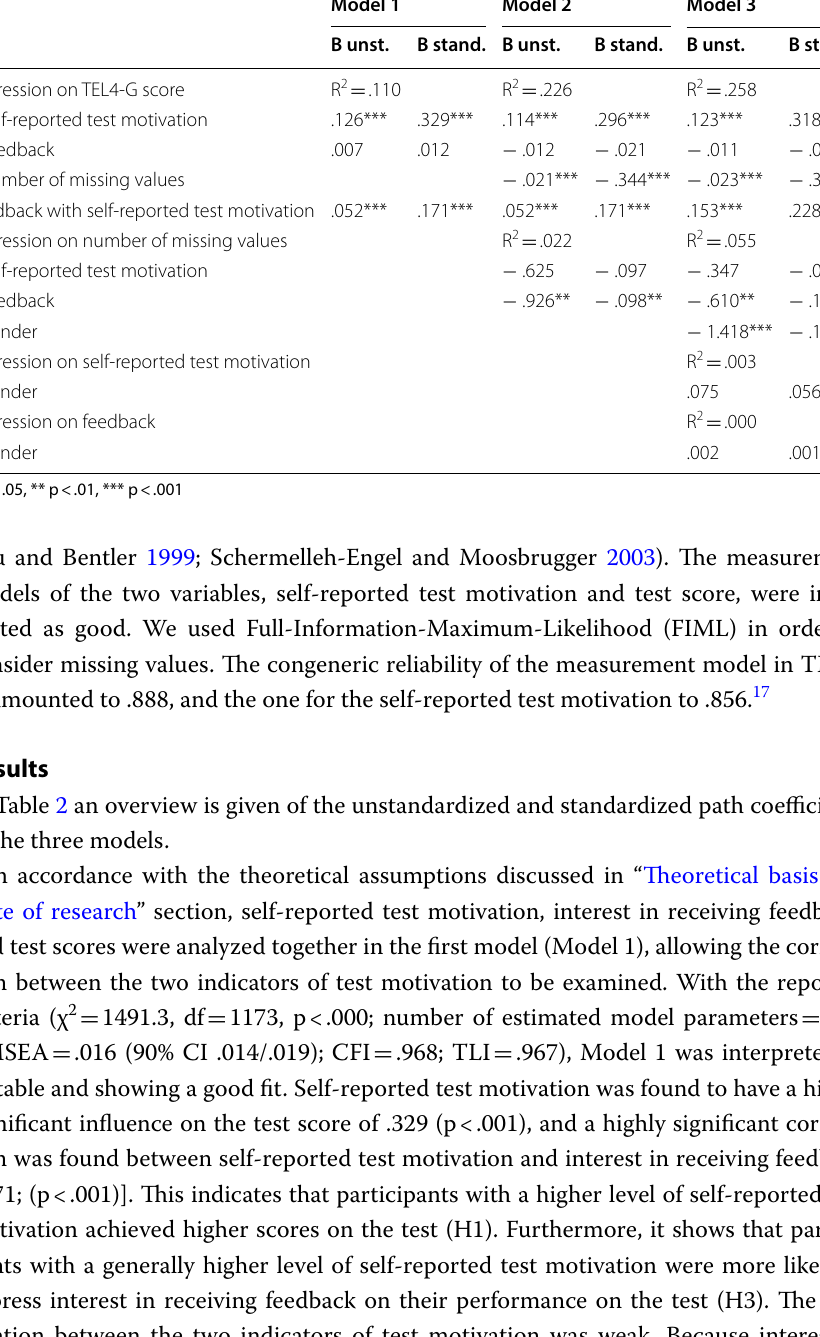
Table 2 Unstandardized and standardized path coefficients in the three models